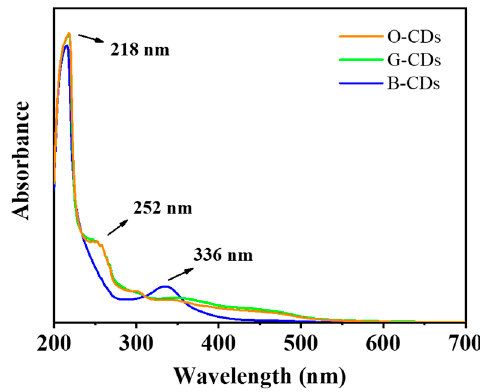
Figure 3. UV/vis absorption spectra of O-CDs, G-CDs, and B-CDs in ethanol solution ( c = 0.1 mg/mL).